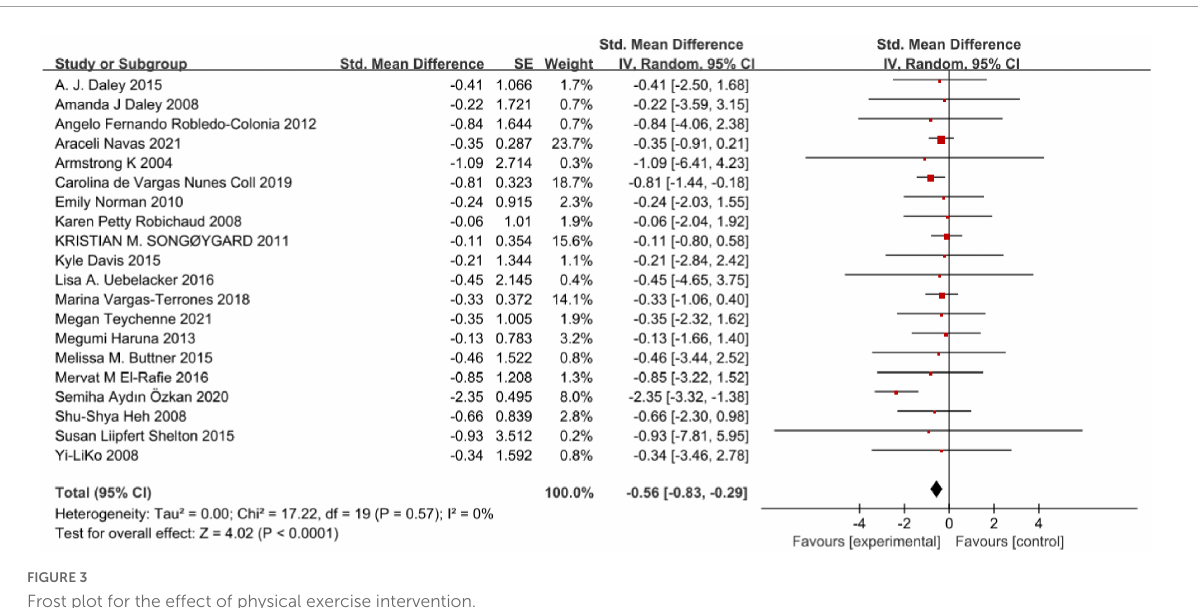
forms that included “individual-based [SMD = − 0.36, 95% CI ( − 0.60, − 0.13), P = 0.003, I 2 = 0, seven studies],”